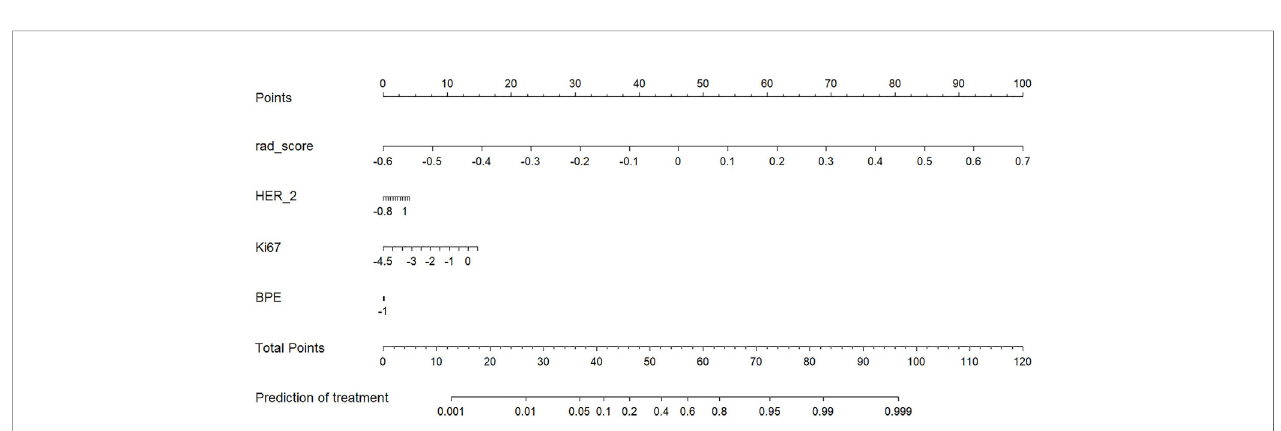
FIGURE 4 | Predicted scores of patients in (A) the training and (B) validation set. The red color indicates NAC-ineffective patient and blue color indicates NAC- effective patient. The bars above the horizontal line indicates NAC-effective patient and the bars below the horizontal line indicates NAC-ineffective distinguished by the radiomics score.